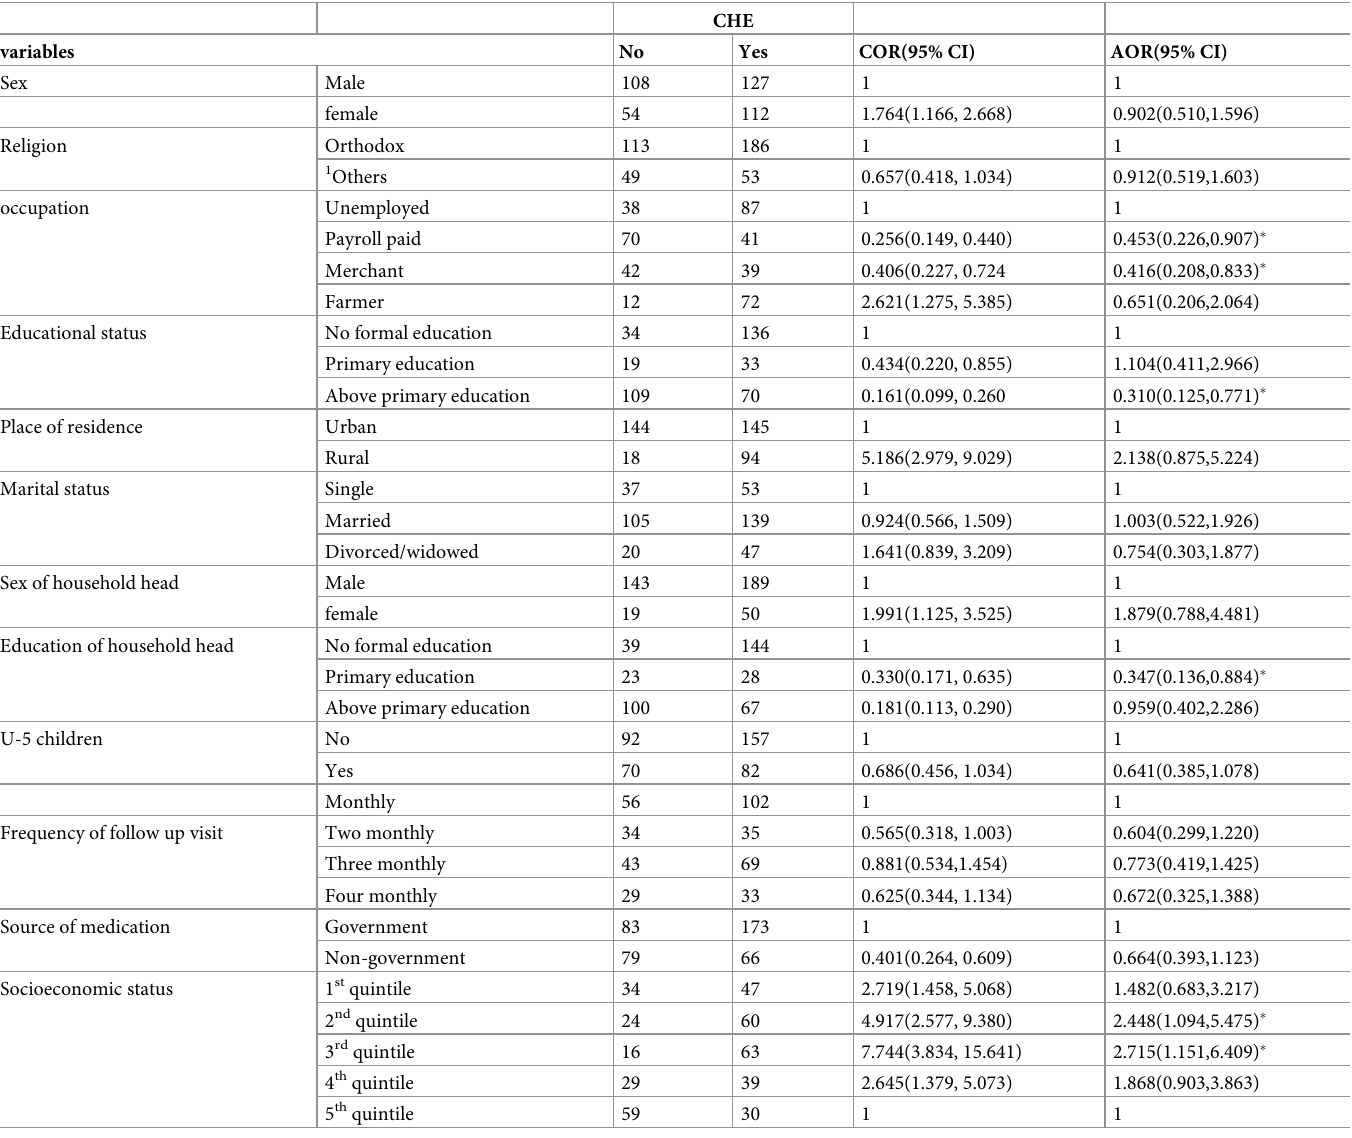
Table 6. Logistic regression results on predictors of catastrophic expenditure of diabetic care among diabetes mellitus patients in public hospitals of Bahir Dar city administration, Ethiopia,